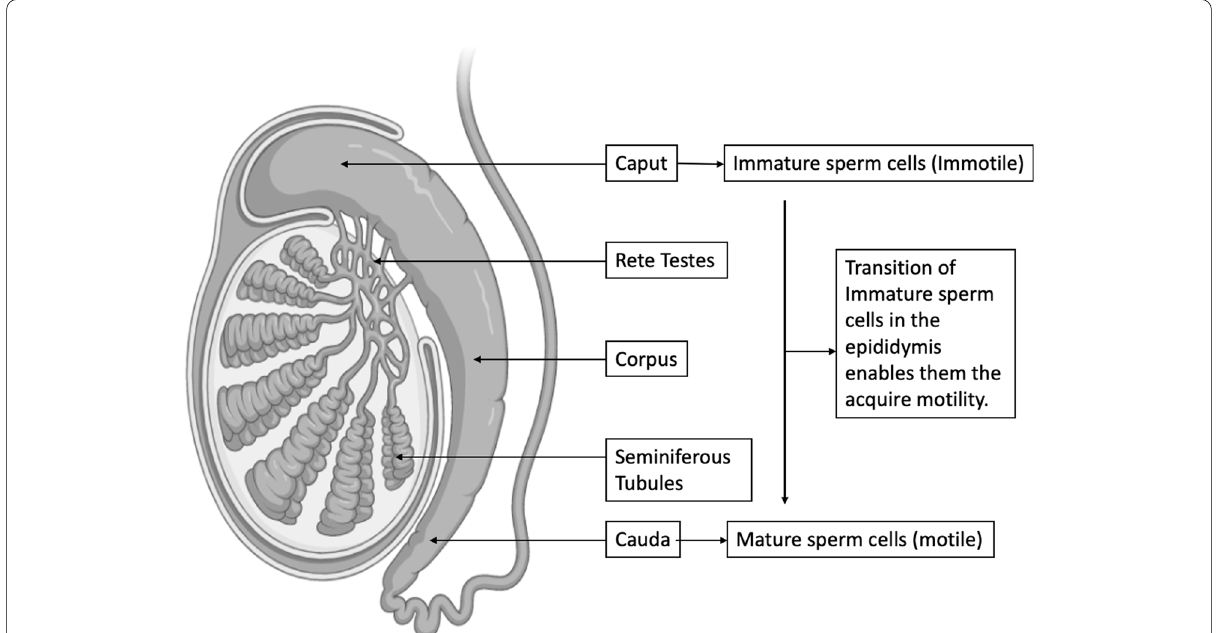
Fig. 1 Diagram of the epididymis. The epididymis is comprised of four anatomical regions: the initial segment, caput, corpus, and cauda. Alterations in membrane composition are driven by concentration gradients of specific enzymes and molecules along the tubule lumen. Sperm maturation occurs during epididymal transit by the interaction of sperm cells with the unique luminal environment of each epididymal